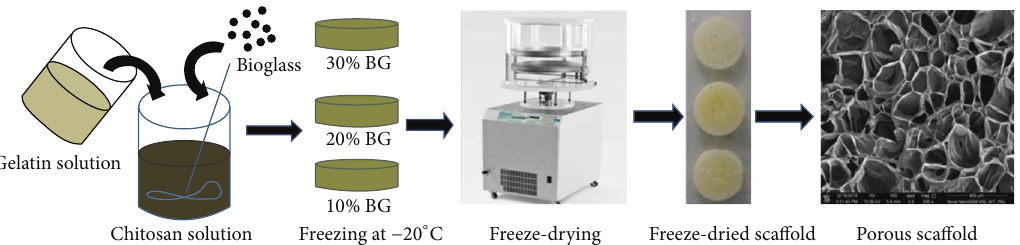
Figure 1: Fabrication procedure for the GCB